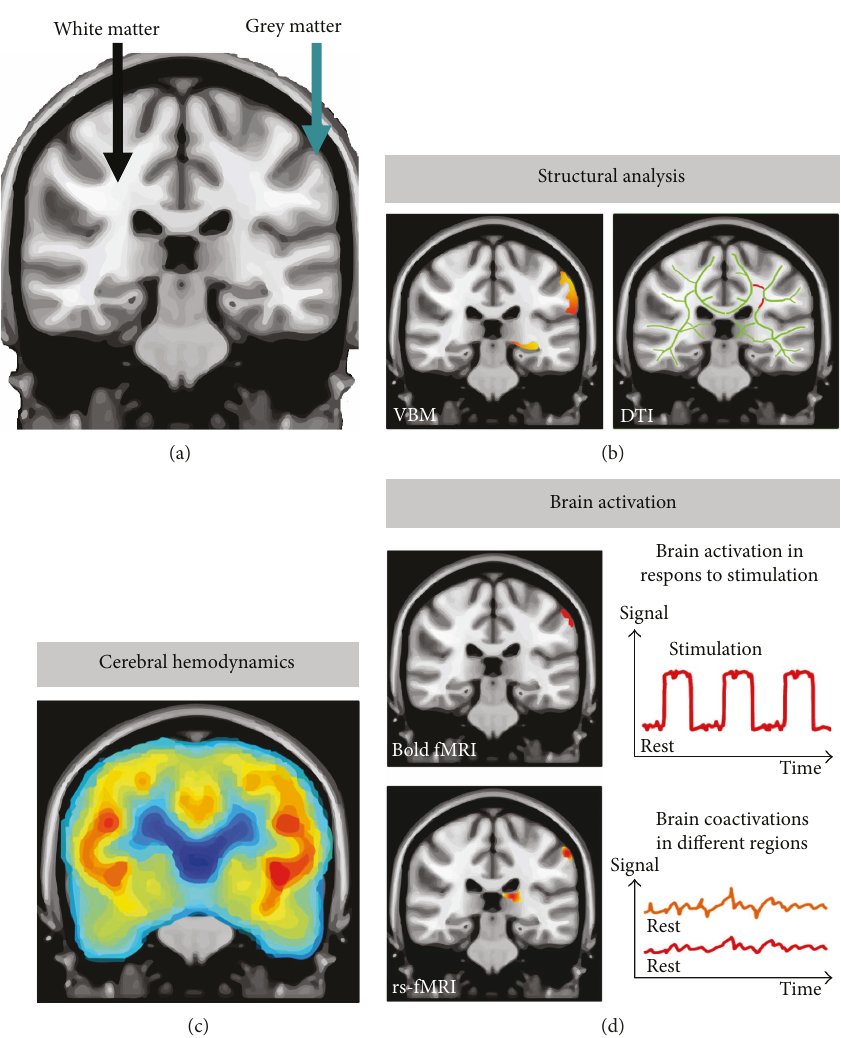
Figure 2: A brief overview of MRI modalities to elucidate cerebral pathophysiology in relation to POCD and POD. (a) Anatomical MRI scan showing white matter and grey matter of the brain. (b) (Left side) Voxel-based morphometry (VBM) analyses the anatomical images to determine possible changes in grey matter volume and morphometry. (b) (Right side) Di ff usion tension imaging (DTI) can characterize white matter integrity and tracts. These modalities can potentially reveal even minor neuroplasticity. (c) Measurement of cerebral hemodynamics with intravenous (IV) contrast permits determination of, for example, cerebral blood fl ow (CBF), cerebral blood volume (CBV), and cerebral oxidative metabolic rate (CMRO ), while CBF also can be measured without IV contrast by arterial spin labeling 2 (ASL). (d) Functional MRI can indirectly determine neuronal activation by measuring concomitant changes in blood fl ow. Blood- oxygenation-level dependent (BOLD) fMRI signal is useful in investigating brain activation to an explicit task. Resting state fMRI (rsfMRI) can reveal coactivation of distinct regions across the brain in patients that are not performing an explicit (Figure 2). Voxel-based morphometry (VBM) and surface- based analysis (SBA) of anatomical MRI data permit detec- tion of subtle changes in especially the grey matter [63, 64].